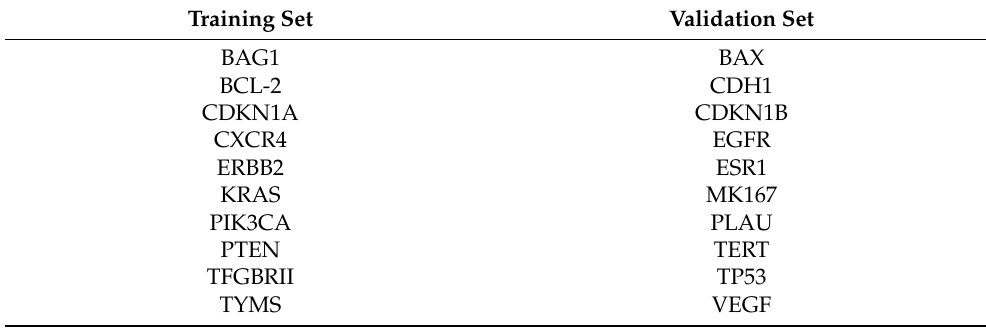
Table 1. Known CRC biomarkers used in this